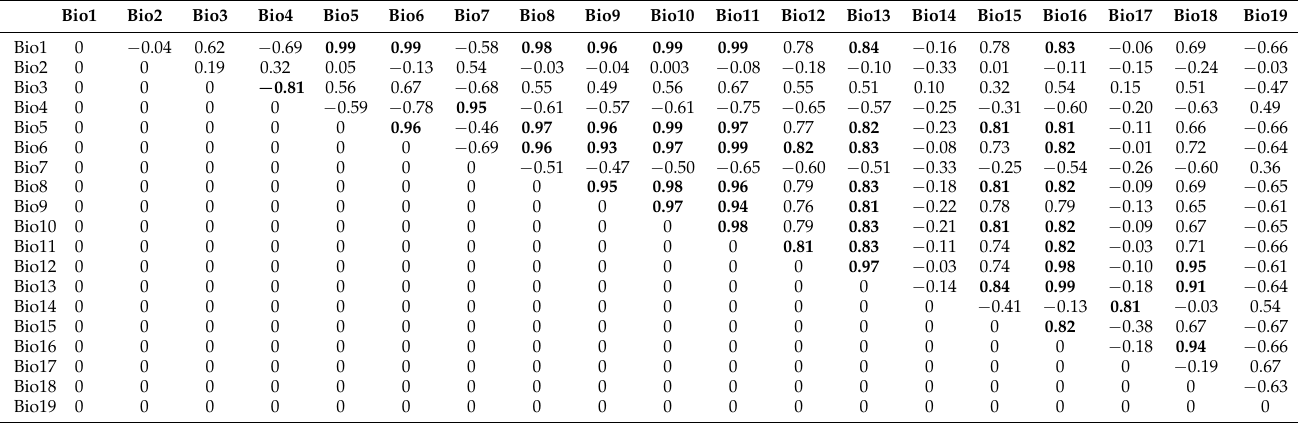
Table 1. Pearson’s correlation coefficients among the 19 bioclimatic variables (correlations with r ≥ |0.80| are shown in bold).